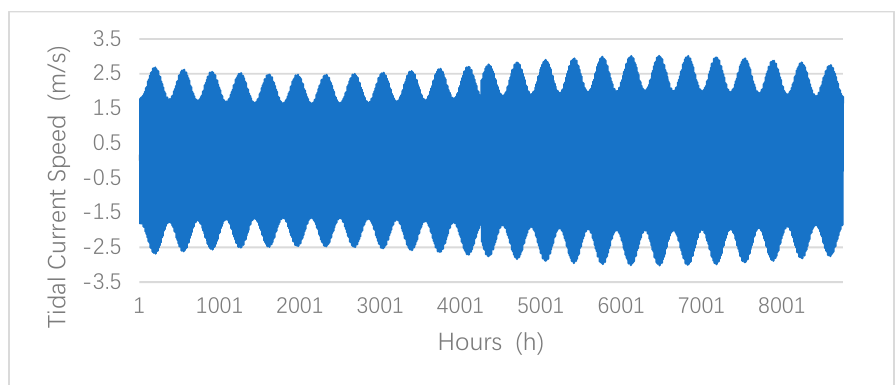
Figure 4. Annual tidal current speed of the studied site.